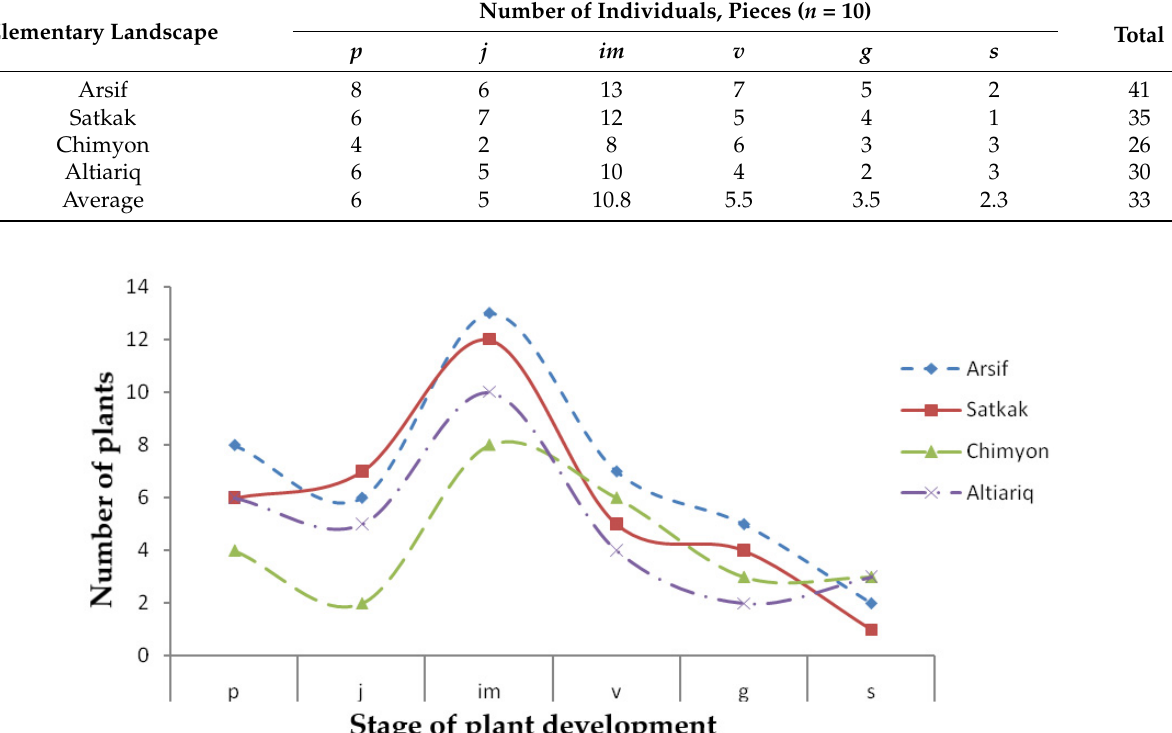
Figure 3. Graph of C. spinosa L. cenopopulation in elementary landscapes in colored curved lines. x -axis— p —grass, j —juvenile, im —immature, v —virginil, g—generative, s —senile, y -axis—number of plants, units per 10 m 2 , in each stage experiments.